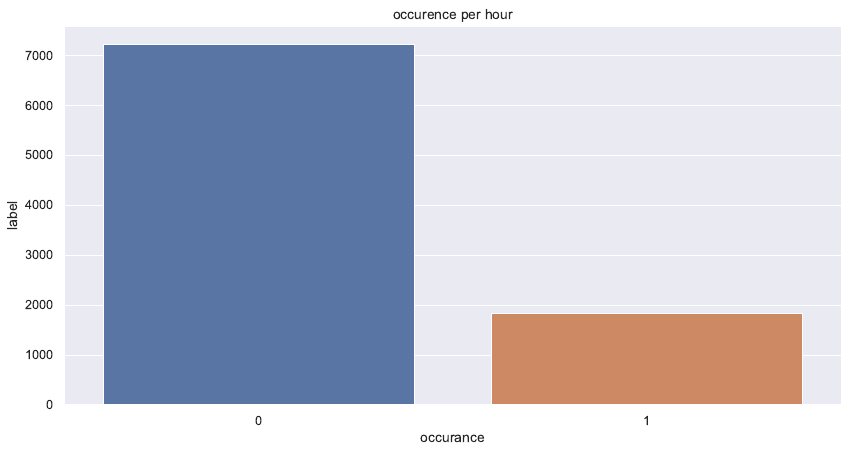
Figure 7. Binary data distribution.